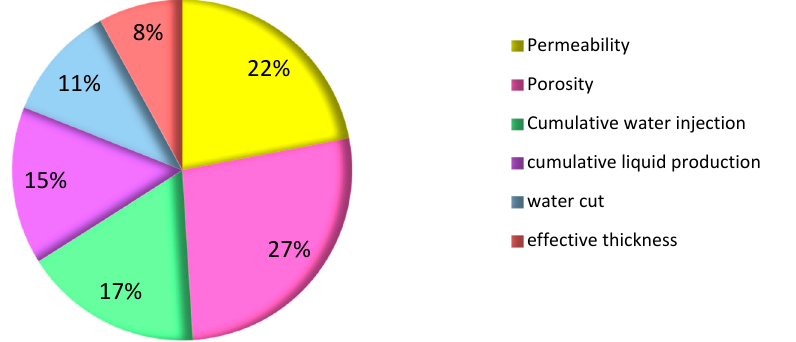
Figure 7. Importance of indices to classification.